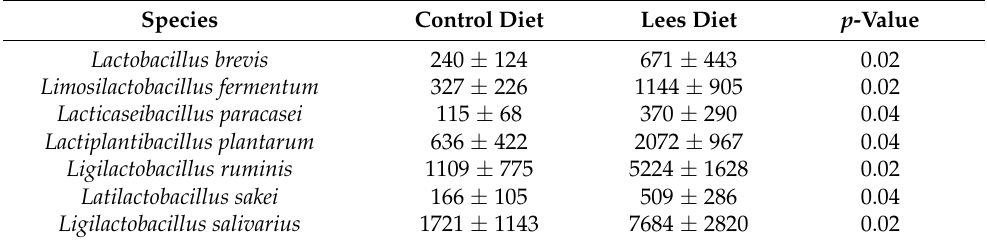
Table 4. Differences regarding abundance of bacteria from the family Lactobacillaceae between rats with control and lees diet. Values are mean ± standard deviation.